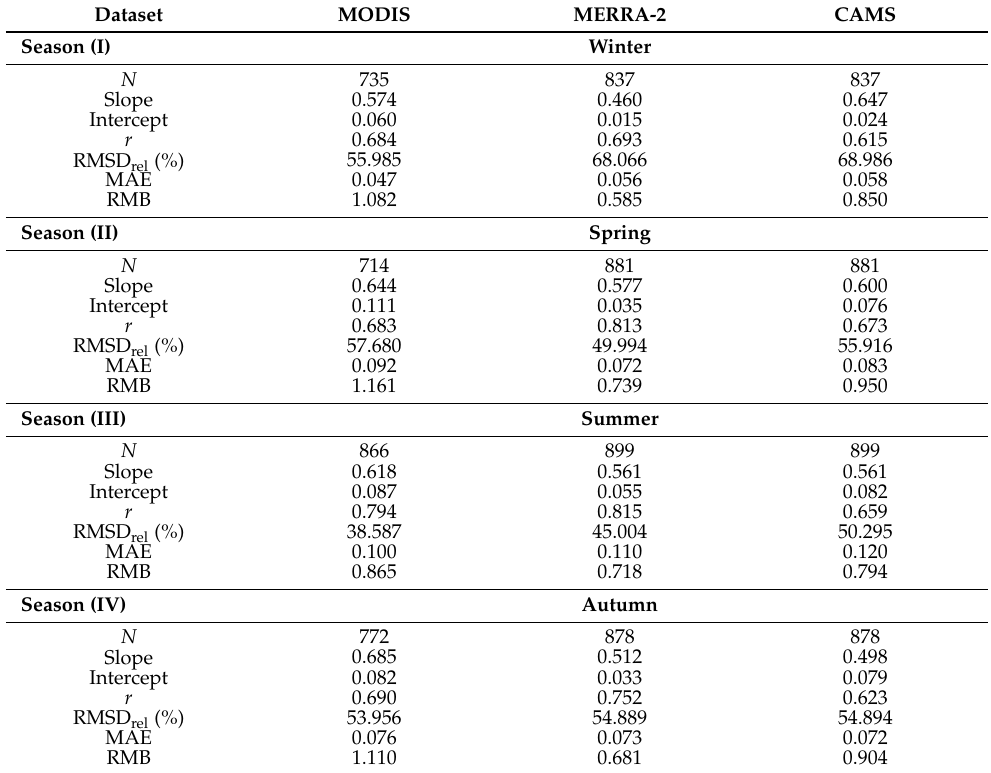
Table A2. AOD seasonal statistical parameters as derived from the comparison between MODIS, MERRA-2, CAMS and AERONET observations over Saada.